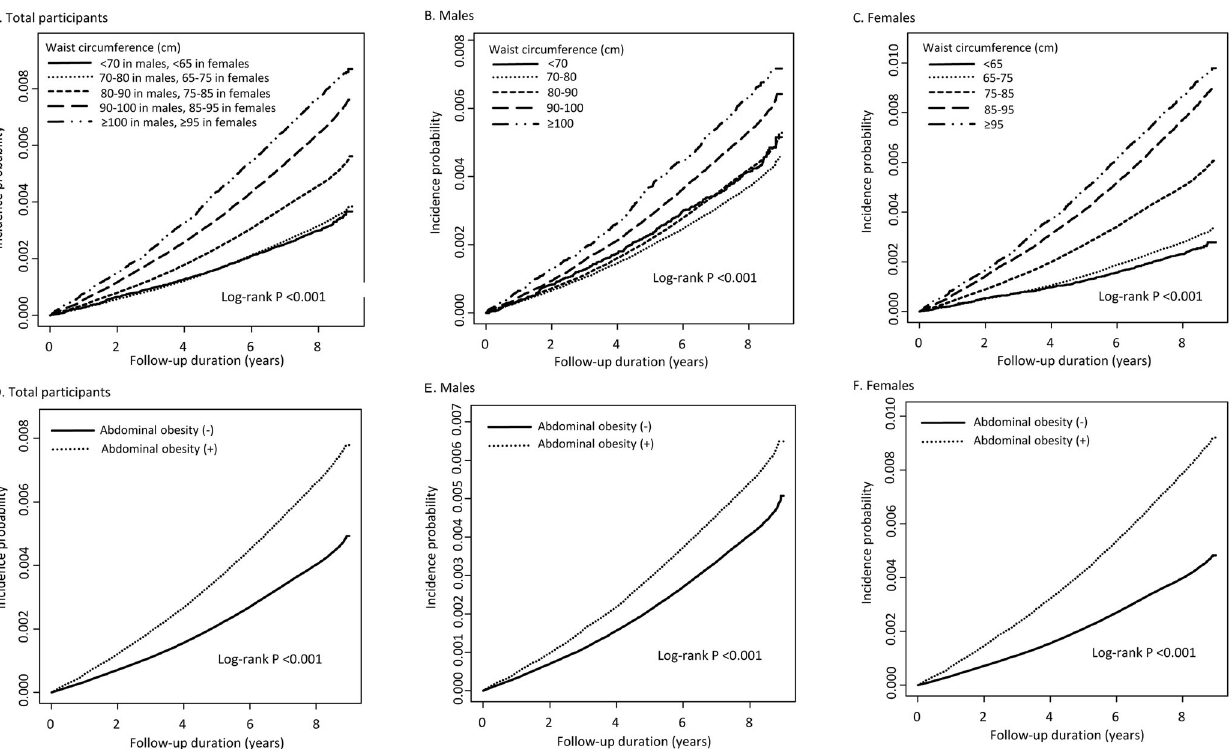
Fig. 1 Kaplan – Meier estimates for the probability of incident Parkinson's disease according to waist circumference and the presence of abdominal obesity (all log-rank P values < 0.001). The probability of incident Parkinson's disease according to waist circumference was analyzed for total participants ( A ), males ( B ), and females ( C ). Analysis according to the presence or absence of abdominal obesity among total participants ( D ), males ( E ), and females ( F ) were also